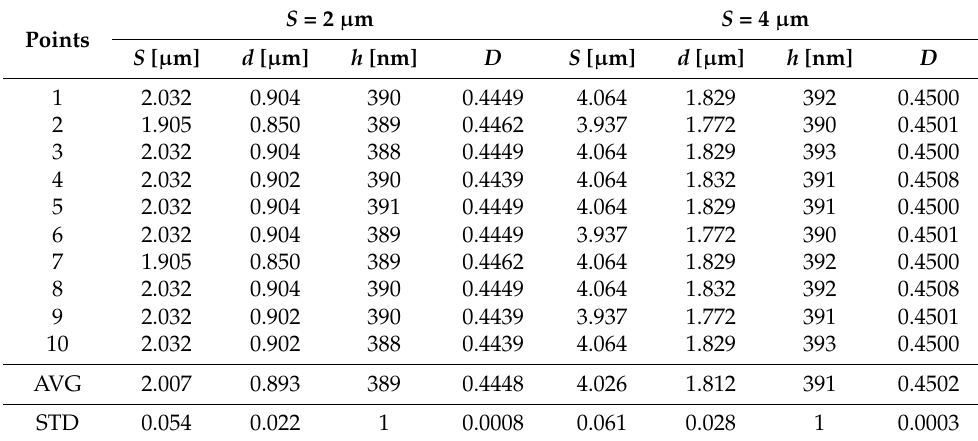
Figure 8. Parameter measurements for grating profiles observed with confocal microscopy. The lateral resolution of the confocal microscope was 0.12 µ m and the vertical was 0.01 µ m. S , d and h represents period, ridge width and etching depth of gratings, respectively. ( a , b ) are the local profiles of 2 µ m and 4 µ m gratings. Table 1. Measurement data for the gratings with periods of 2 and 4 μm.